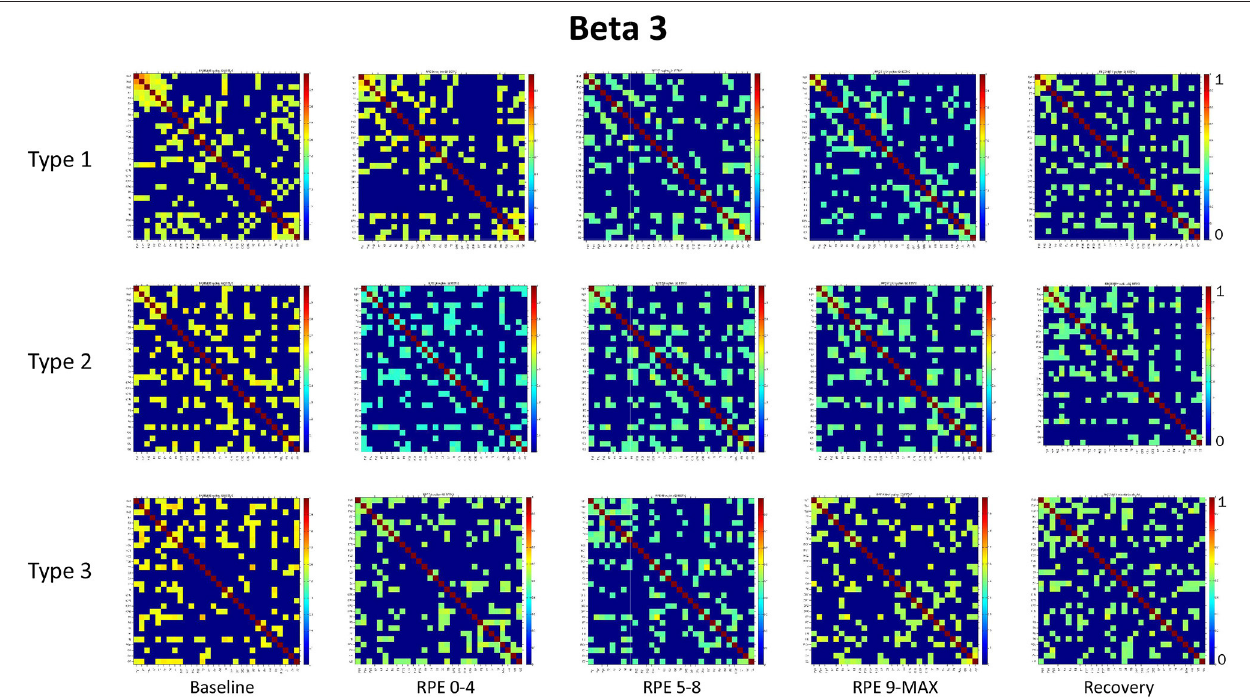
FIGURE 4 | Coherence matrices for each type of performance during different time periods of the protocol in the beta 3 band. Red color indicates high values of coherence whereas the blue color indicates low values of coherence.